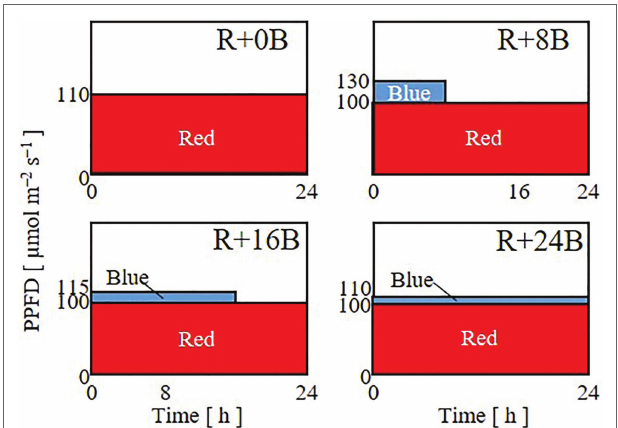
FIGURE 2 | Lighting patterns used in Experiment 2. Plants were subjected to 24-h red-light irradiation with a PPFD of 110 μ mol m − 2 s − 1 (R + 0B) or under 8 (R + 8B), 16 (R + 16B), or 24-h (R + 24B) blue-light irradiation with PPFDs of 30, 15, and 10 μ mol m − 2 s − 1 , respectively, supplemented with 24-h red-light irradiation with a PPFD of 100 μ mol m − 2 s − 1